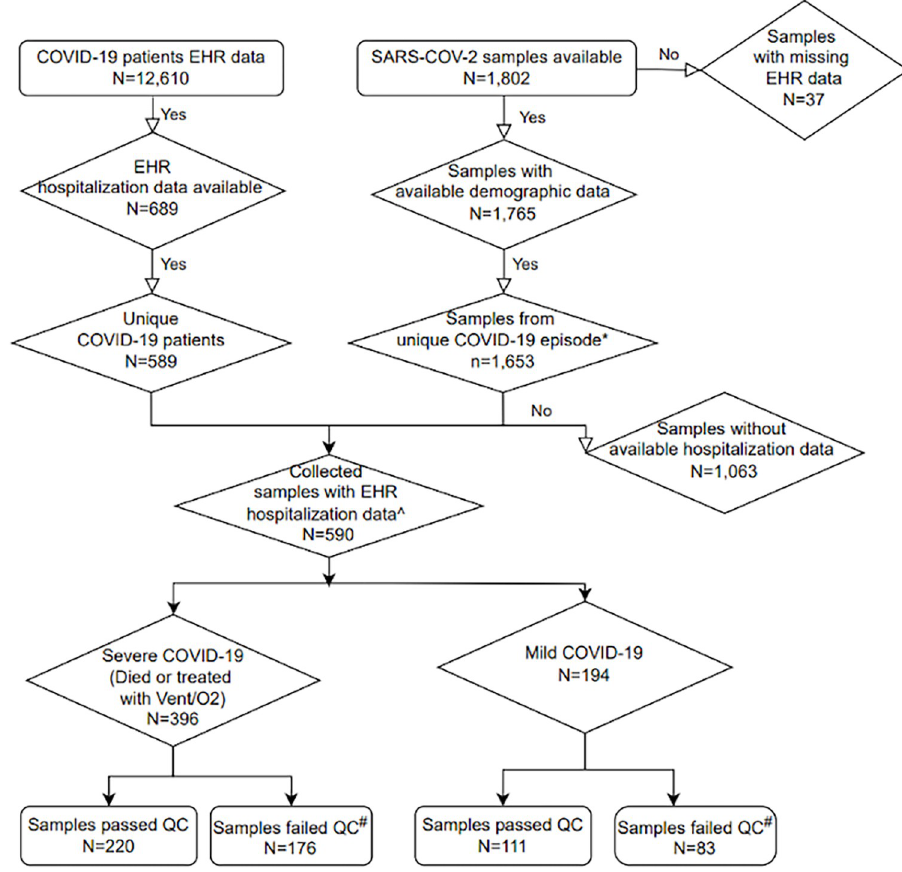
Fig 1. Sample selection, inclusion, and exclusion of the analysis cohort, UPMC, March 2020- May